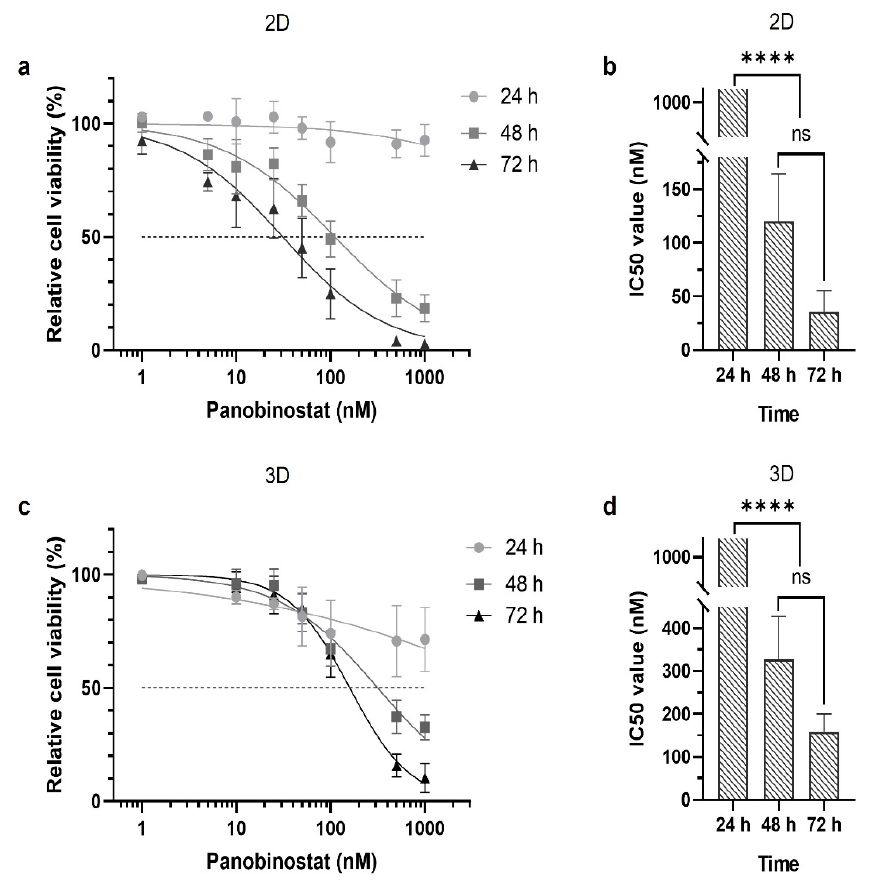
Figure 7. Dose–response curves for panobinostat treatment of primary human kidney fibroblasts in 2D and 3D culture. Monolayer (2D) cultured kidney fibroblast ( a , b ) and bioprinted (3D) kidney fibroblast ( c , d ) were treated with increasing concentrations of panobinostat. Cell viability was evaluated by XTT assays after 24, 48, and 72 h. Dose–response curves ( a , c ) and the calculated IC 50 values ( b , d ) are shown. Data are presented as mean ± standard error of the mean; n = 3. **** p < 0.0001. Table 2. IC 50 values of human kidney fibroblast treated with panobinostat in 2D culture or 3D con- structs.